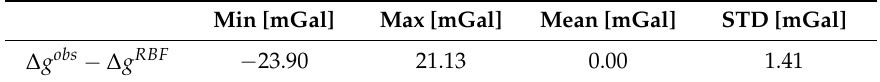
Table 3. The statistics of the discrepancies between the predicted and observed gravity anomalies.